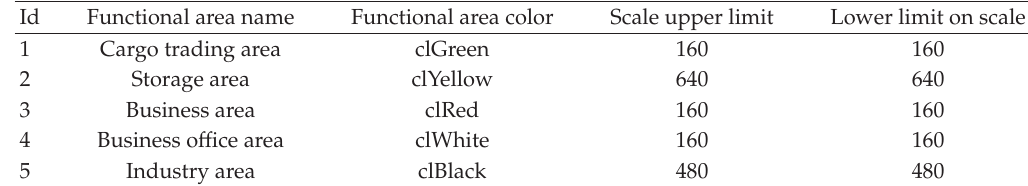
Table 1: The situation of functional